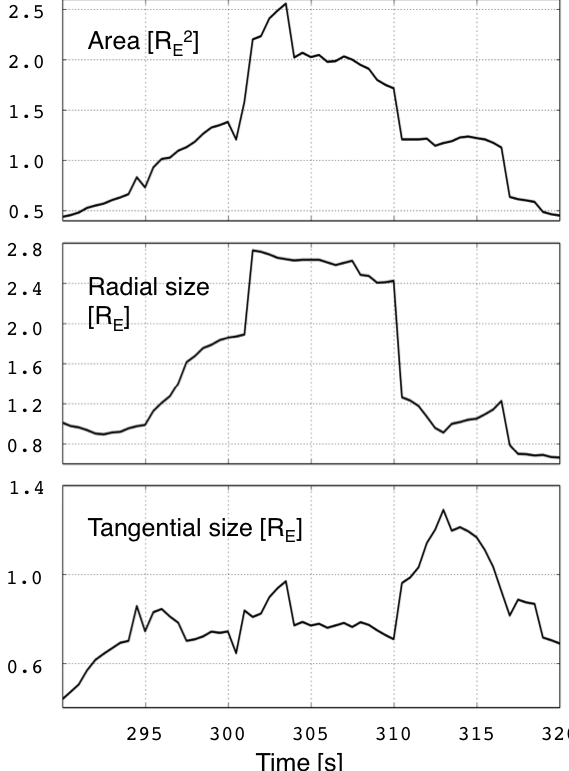
Figure 6. The jet area, radial, and tangential size as a function of time. The area has been calculated based on both (i) the Archer and Horbury and (ii) the Plaschke criteria, while the radial size is the subtraction of the maximum and minimum radial distance of the jet boundary positions, reflecting the jet maximum extent. The tangen- tial size is the effective jet width, and it is calculated by dividing the jet area by the radial